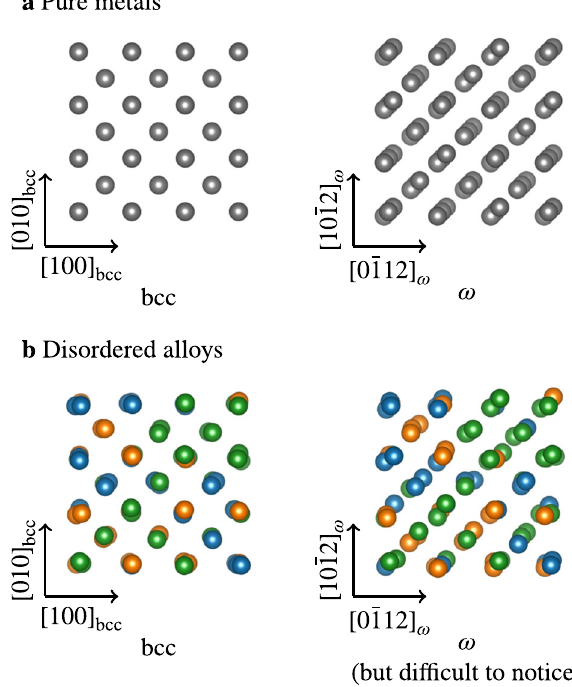
Fig. 1 Schematics of the bcc and ω structures. a Pure metals. b Disordered alloys. Spheres with different colors represent different chemical elements. Visualization was performed using VESTA 55 . symmetry differences between the two structures. For a typical relaxed con fi guration of a disordered alloy (Fig. 1b), however, a distinction of the two structures is much less straightforward due to the chemical disorder, which breaks the ideal crystallographic symmetries in both structures. This becomes even more challen- ging if the relaxed ω structures show line defects 21,24 .